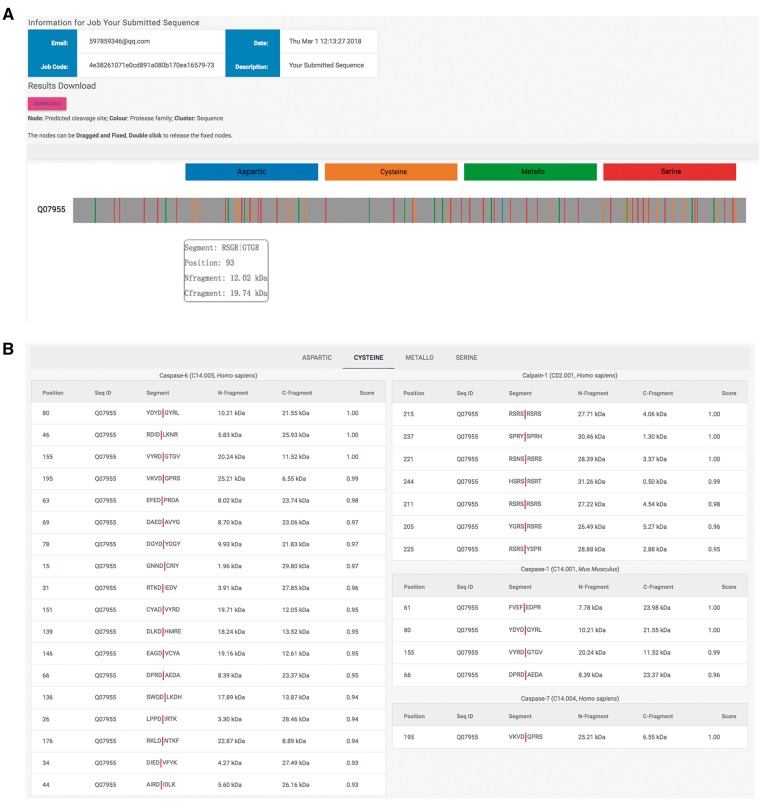
Example output of the iProt-Sub Web server.